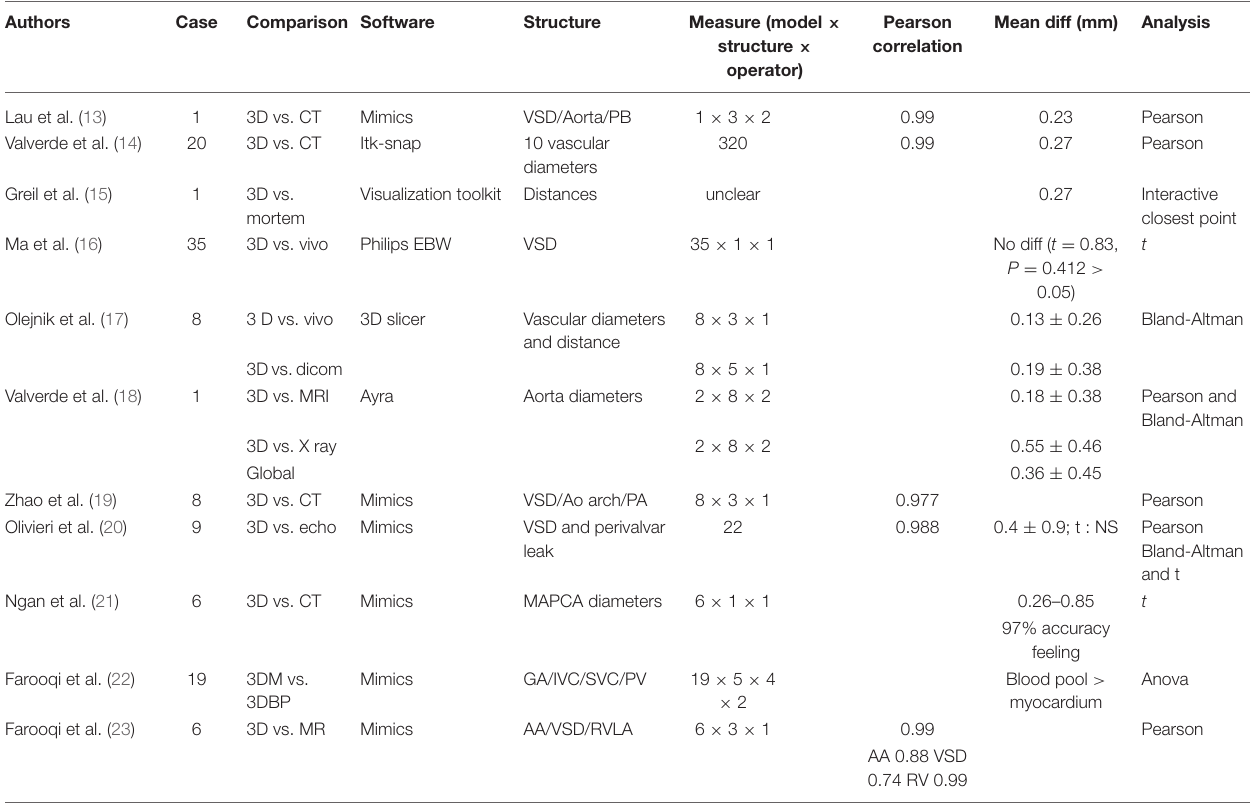
CT, computed tomography; MRI, Magnetic Resonance Imaging; 3DM, 3D myocardium; 3DBP, 3D bloodpool; VSD, ventricular septal defect; PB, pulmonary branch; Ao Arch, aortic arch; MAPCA, major aortopulmonary collateral artery; SVC, superior vena cava; IVC, inferior vena cava; Ao, Aorta; PA, pulmonary artery; PV, pulmonary valve; AA, aortic annulus;